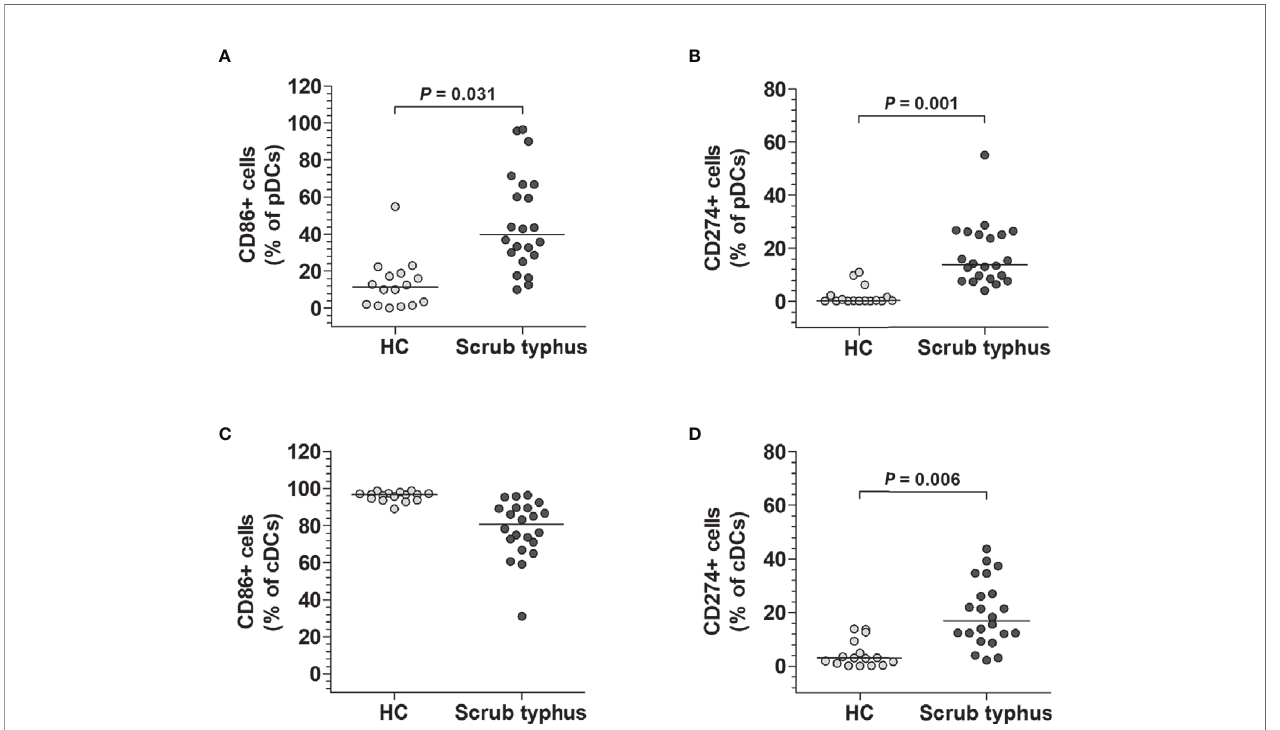
FIGURE 2 | Phenotypes of circulating pDCs and cDCs in scrub typhus patients. Freshly isolated PBMCs were stained with APC-conjugated anti-CD11c, anti-CD86, and anti-CD274; BV421-conjugated anti-HLA-DR; FITC-conjugated Lineage Cocktail 1; and PE-conjugated anti-CD86, anti-CD123, and anti-CD274 mAbs and then analyzed by fl ow cytometry. (A, C) , Percentages of CD86-expressing pDCs and cDCs. (B, D) , Percentages of CD274-expressing pDCs and cDCs. The data were obtained from 16 HCs and 22 scrub typhus patients. The symbols represent individual subjects and the horizontal lines are median values. P values were calculated by ANCOVA